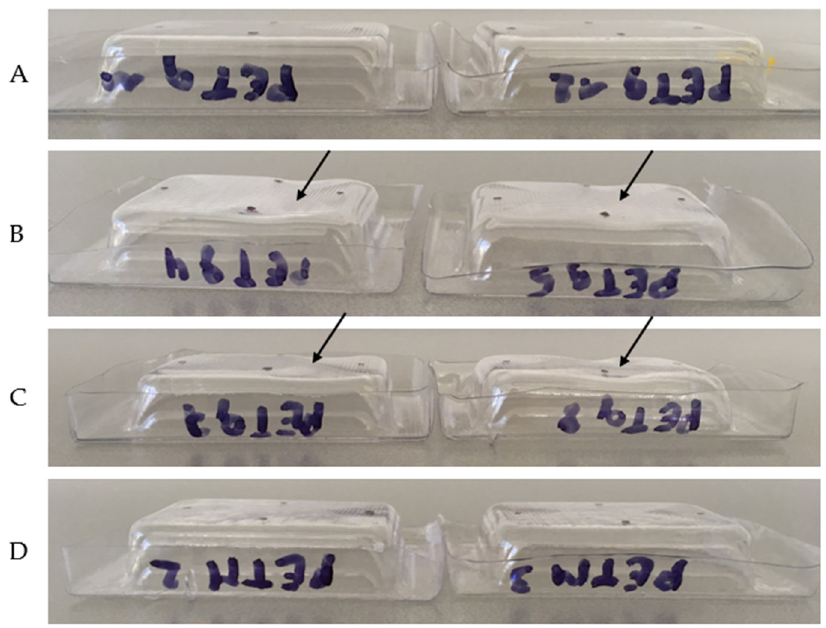
Figure 13. PETg trays exposed to hot-fill temperatures of 75 °C ( A ), 85 °C ( B ) and 95 °C ( C ), and PETM trays exposed to hot-fill temperatures of 95 °C ( D ).